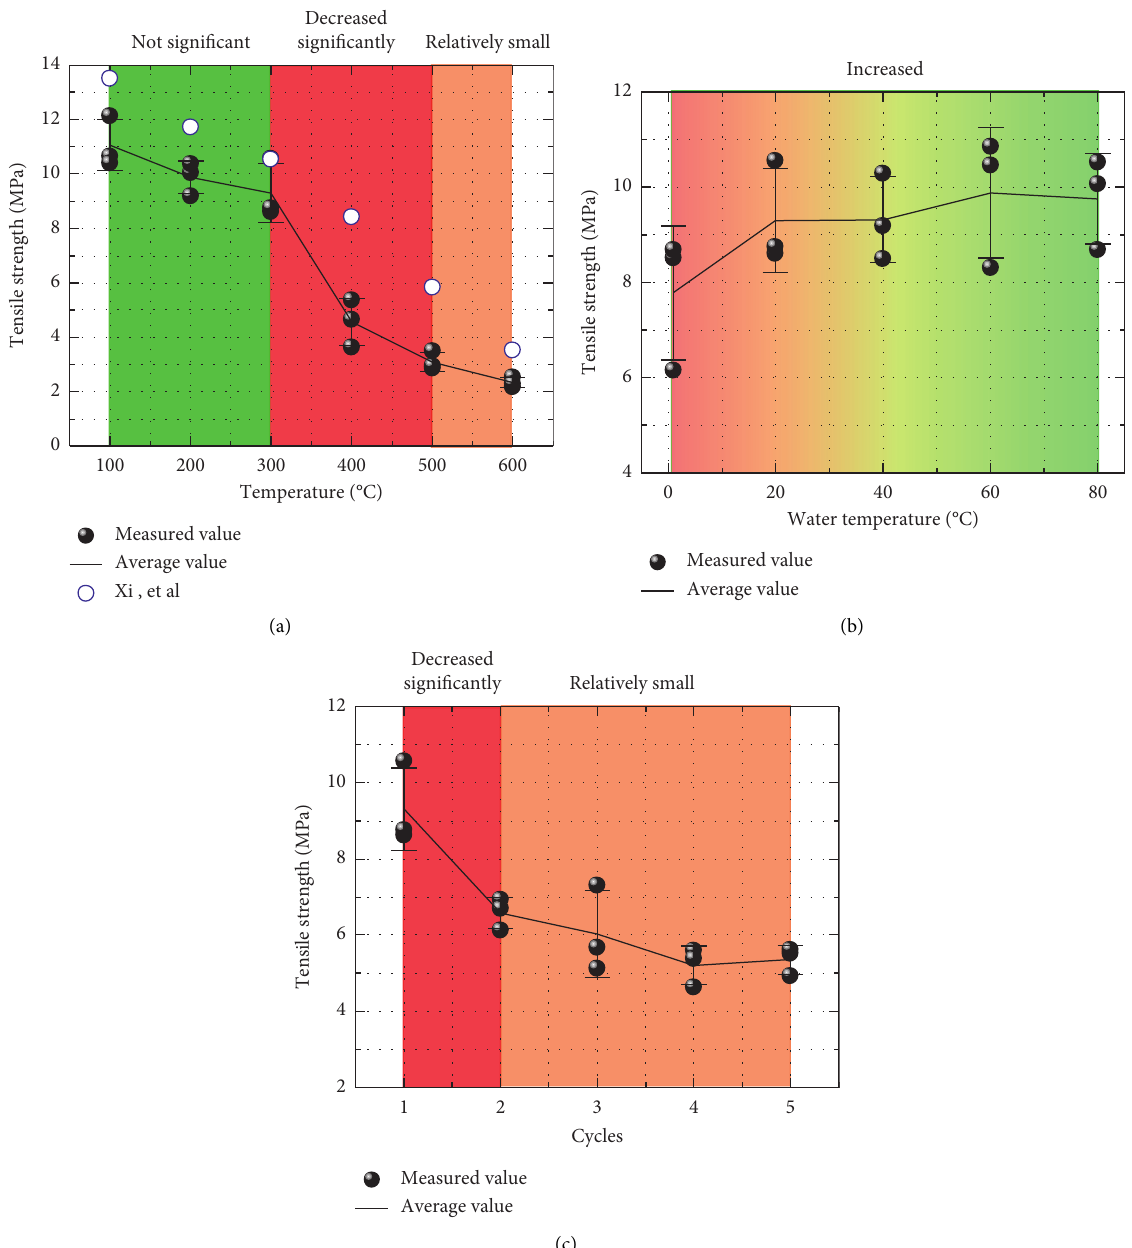
Figure 6: Tensile strength of the specimens under different conditions of water cooling at high temperatures. (a) HDR temperature. (b) Water temperature. (c) The number of heating-cooling